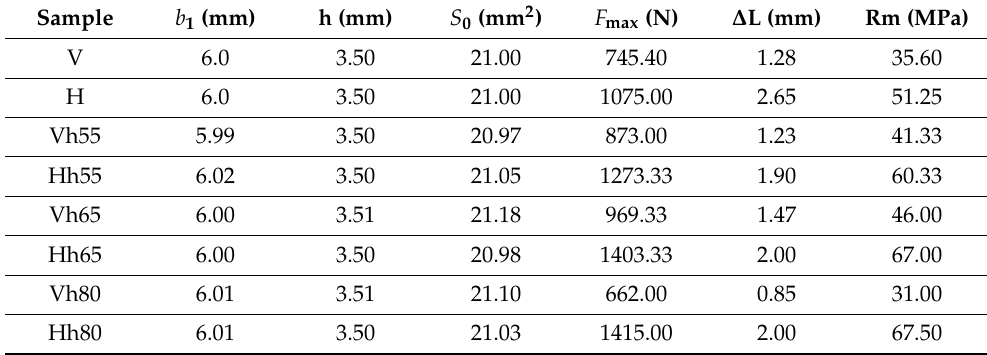
Table 2. The tensile test results of the heat-treated vertically orientated (V) and horizontally orientated (H) specimens as a function of the heat treatment temperature.